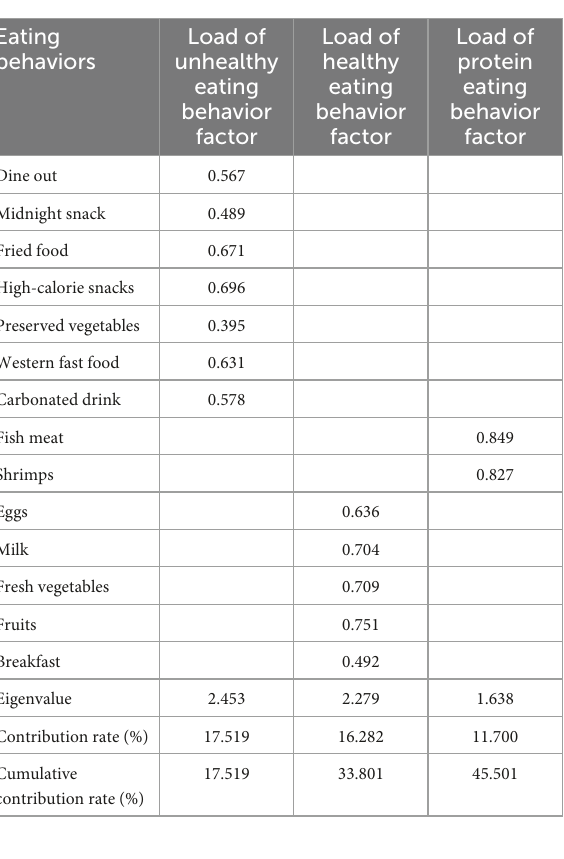
TABLE 1 Exploratory factor analysis of eating behavior frequency.